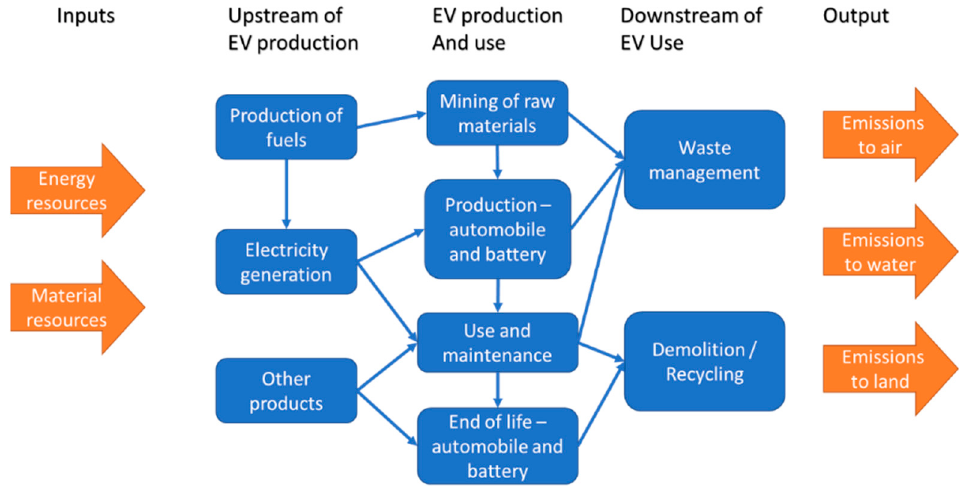
Figure 1. Stages in the lifecycle of an electric vehicle.